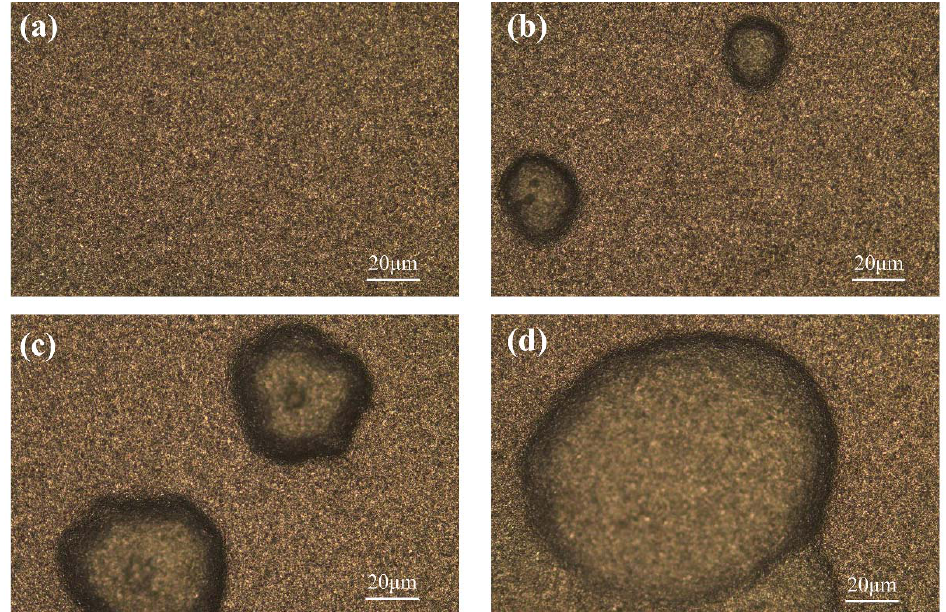
Figure 10. ( a ) Uncorroded sample erosion surface; sample erosion surface after ( b ) 12 h, ( c ) 24 h, and ( d ) 36 h of corrosion.